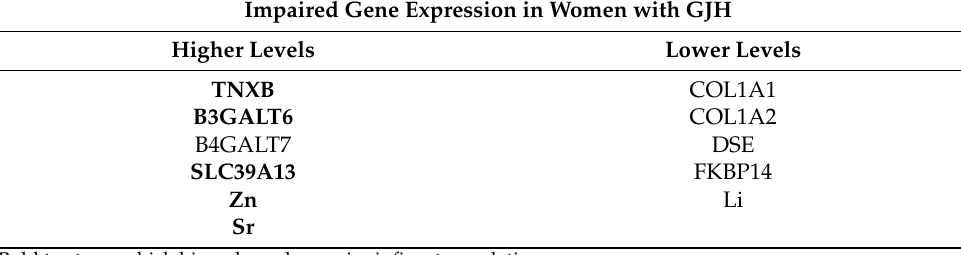
Table 3. Impaired gene expression in women with GJH.